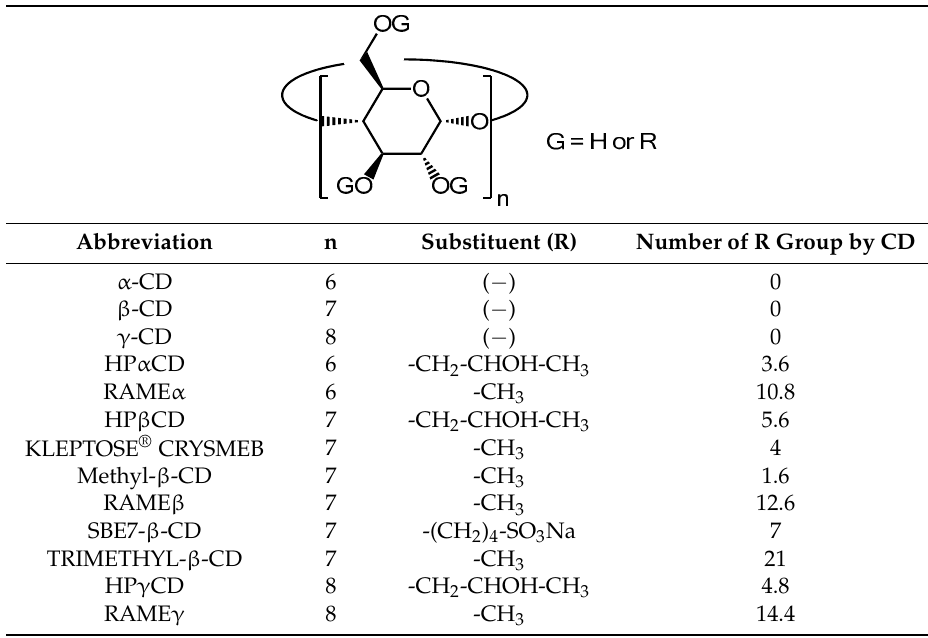
Table 1. Structure of native CDs and common modified CDs.